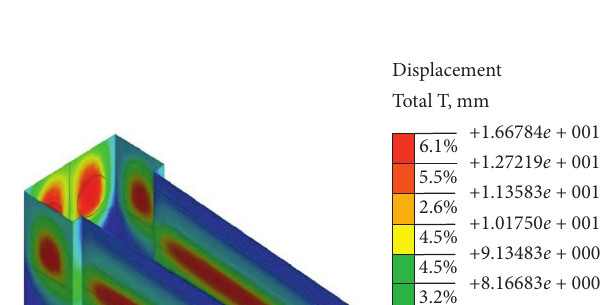
Figure 12: Initial state of formation.